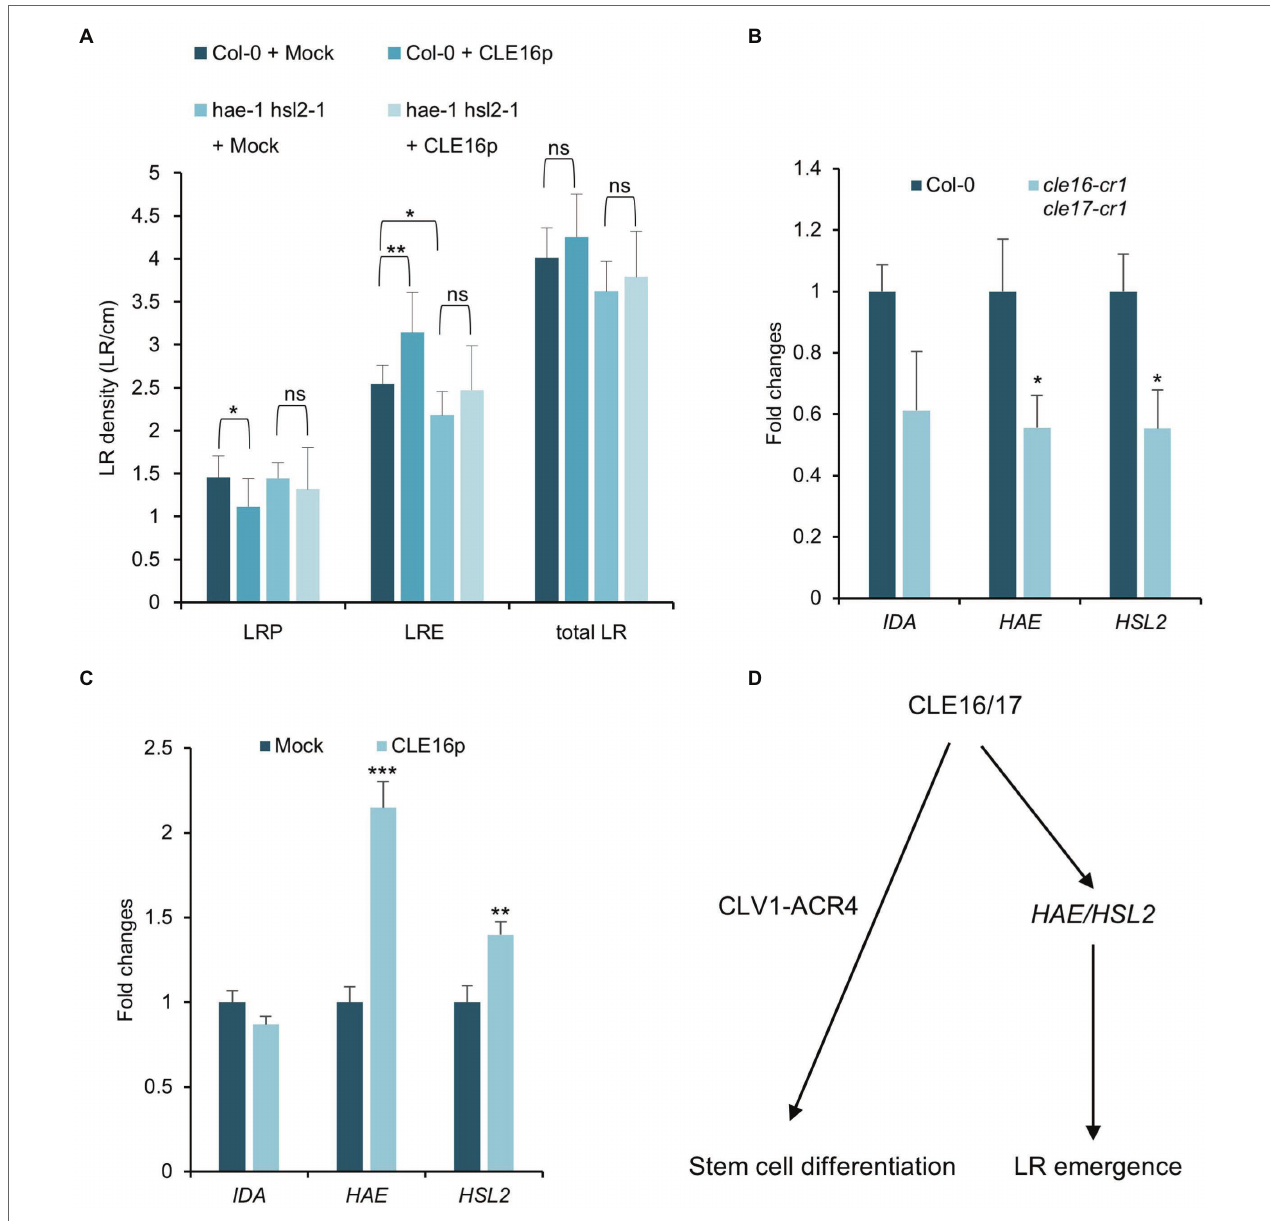
FIGURE 6 | CLE16 / 17 facilitate LR emergence via upregulating the expression of HAE and HSL2 . (A) Quantification of LRP, LRE, and total LR density in the seedlings of Col and hae hsl2 double mutants treated with or without 1 μ M CLE16p. One-way ANOVA followed by Dunnett’s multiple comparisons test, * p < 0.05, ** p < 0.01, and ns not significant. (B,C) Relative expression levels of IDA , HAE , and HSL2 in roots detected by qRT-PCR in cle16 cle17 double mutants compared with wild-type (B) and in CLE16p treatment compared with mock treatment (C) . PCR signals were normalized to wild-type or mock control. Roots were treated with or without 1 μ M CLE16p for 48 h. Error bars represent SD from three biological replicates. Student’s t -test, * p < 0.05, ** p < 0.01, and *** p < 0.001. (D) A simplified working model for CLE16/17 regulating root